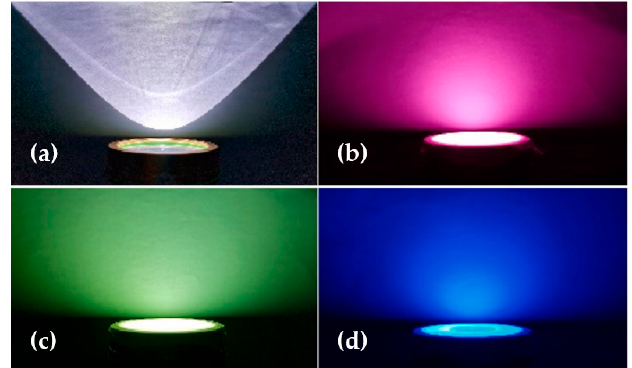
Figure 4. Comparison of ( a ) normal luminescence with ( b ) red, ( c ) yellow, and ( d ) blue colored sca tt ered light of LED chip. From [101], copyright (2021), with permission from Elsevier.